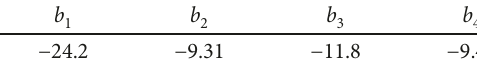
, b , b , and b 1 2 3